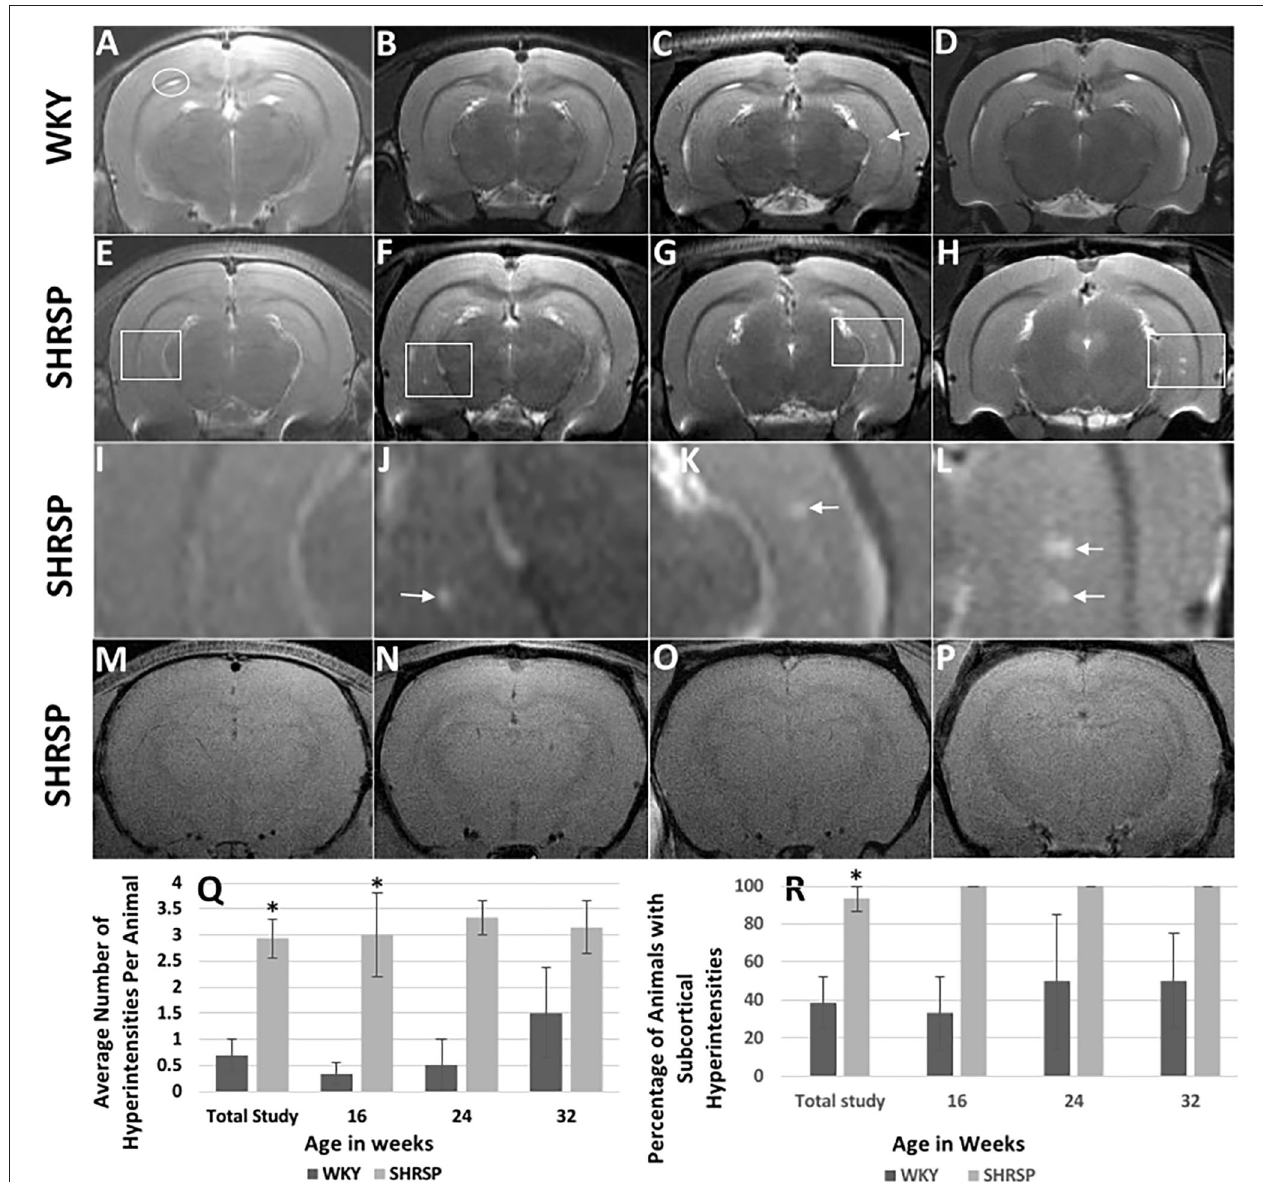
FIGURE 3 | Brain MRI findings in WKY and SHRSP including T2w imaging (A–L) and susceptibility weighted imaging (SWI) (M–P) at the study time points. Compared to WKY, brain MRI T2w imaging of SHRSP showed progression of subcortical hyperintensities with age in terms of number and size. (Q) and (R) show the increase in lesion numbers per animal and percentage of animals which had visible lesions. At 7 weeks of age, brain MRI did not show T2w imaging subcortical hyperintensities in WKY (A) and SHRSP (E) . Early T2w imaging hyperintensities were seen in the hippocampus of SHRSP at 16 weeks (F) while they were largely absent in WKY (B) . Faint subcortical hyperintensities were visible in some WKY at 24 [arrow in (C) ] and 32 weeks of age while all SHRSP showed larger and more frequent subcortical hyperintensities at 24 (G) and 32 (H) weeks of age. White squares in (E–H) highlight areas of the hippocampi where subcortical hyperintensities were seen in SHRSP. (I–L) show four-time magnification of the areas within the white squares in (E–H) . Figure (I) demonstrates normal magnified view of the hippocampus at 7 weeks of age. Arrow in J demonstrates small subcortical hyperintensity at 16 weeks of age while arrows in (K) and (L) demonstrate larger subcortical hyperintensities at 24 and 32 weeks of age reaching a maximum of 0.39mm in diameter at 32 weeks of age (L) . Both WKY and SHRSP showed dilatation of the cerebral spinal fluid folds between the hippocampus and corpus callosum [circle in (A) ]. Microbleeds were not visible on SWI sequences in SHRSP throughout the experiment at 7 (M) , 16 (N) , 24 (O) and 32 (P) , weeks of age. WKY, Wistar Kyoto Rats; SHRSP, Spontaneously Hypertensive Stroke-Prone Rats; * statistically significant difference of P < 0.05. Data represent the mean and standard error of the